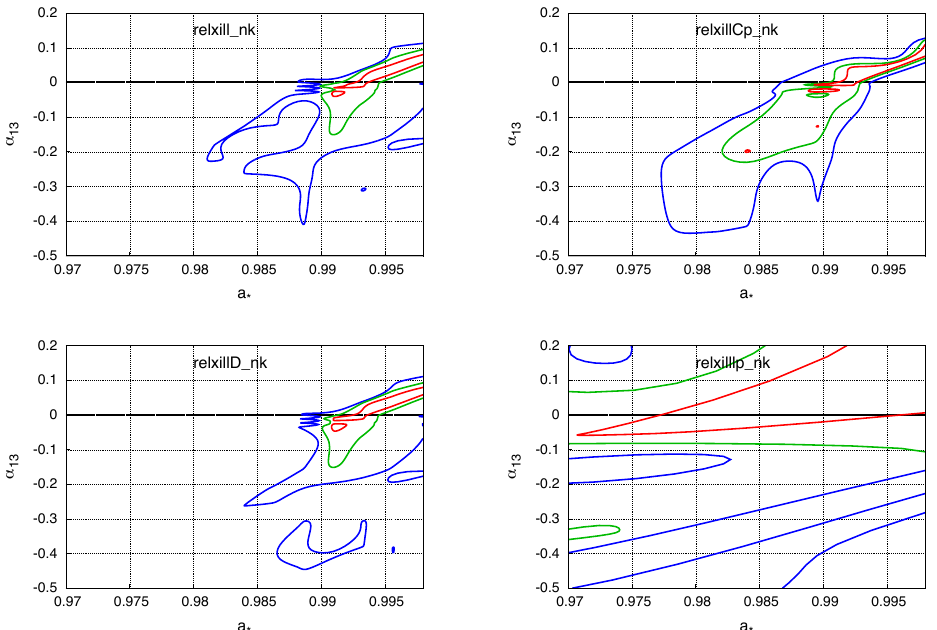
Figure A9. As in Figure A8, but zooming the relevant part of the